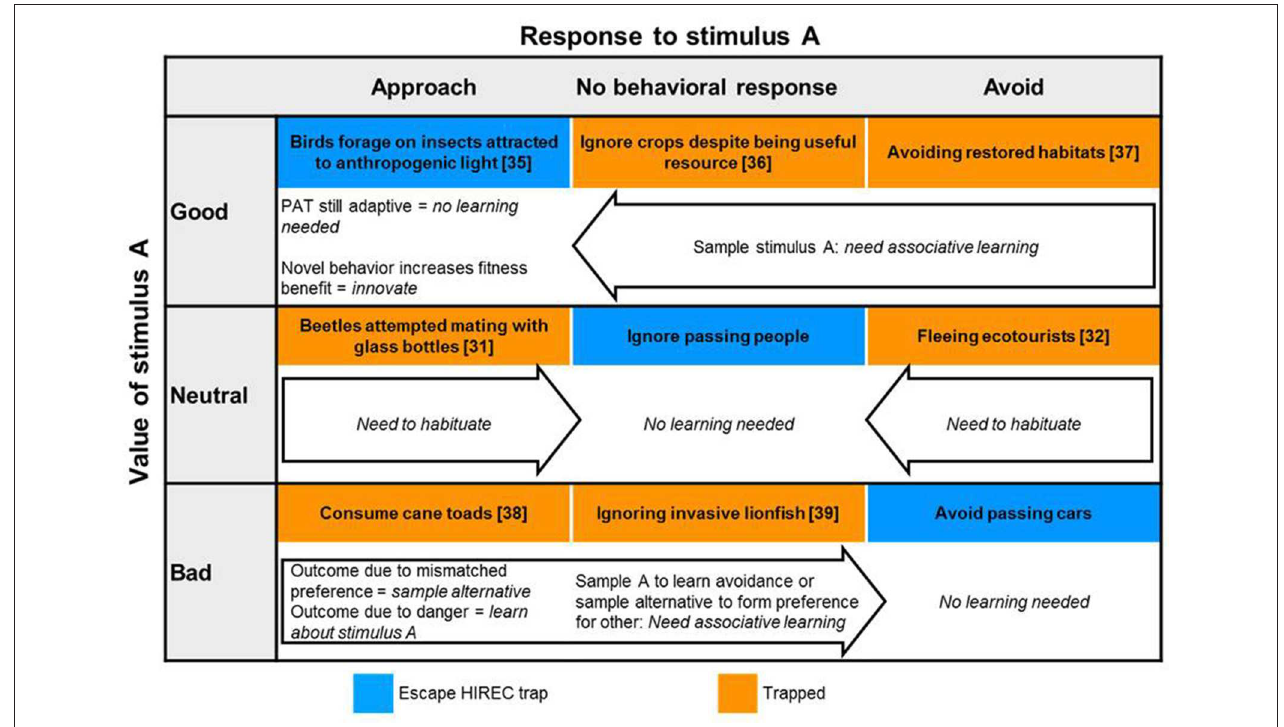
FIGURE 2 | Categories and example consequences for responding to stimuli post-HIREC. Adaptive responses in blue, potential traps in orange. Learning routes for behavioral adjustment listed in arrows. Learning can only occur if potential traps offer multiple opportunities for response. Sampling can involve gathering individual information or social